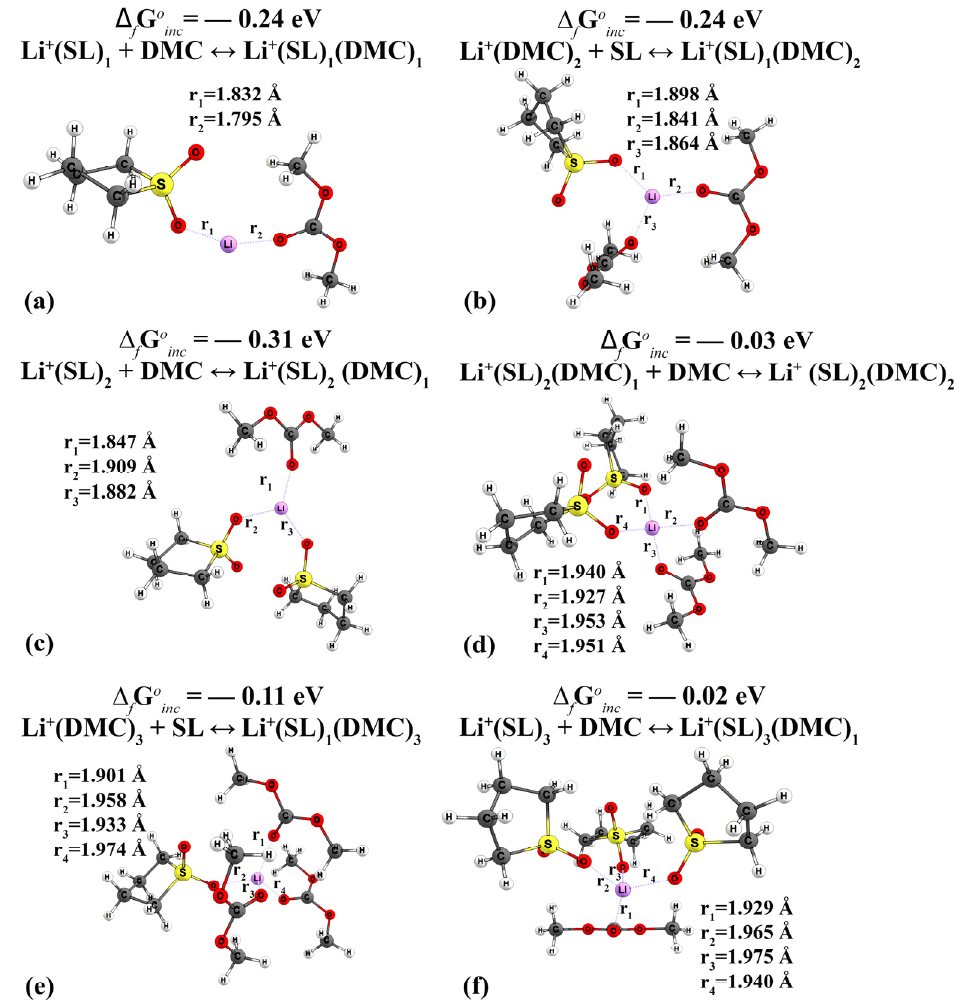
Figure 5. Geometric structure of mixed-type cationic complexes Li + (SL) n (DMC) n : ( a ) Li + (SL) 1 (DMC) 1 , ( b ) Li + (SL) 1 (DMC) 2 , ( c ) Li + (SL) 2 (DMC) 1 , ( d ) Li + (SL) 2 (DMC) 2 , ( e ) Li + (SL) 1 (DMC) 3 , ( f ) Li + (SL) 3 (DMC) 1 . Solvated ionic